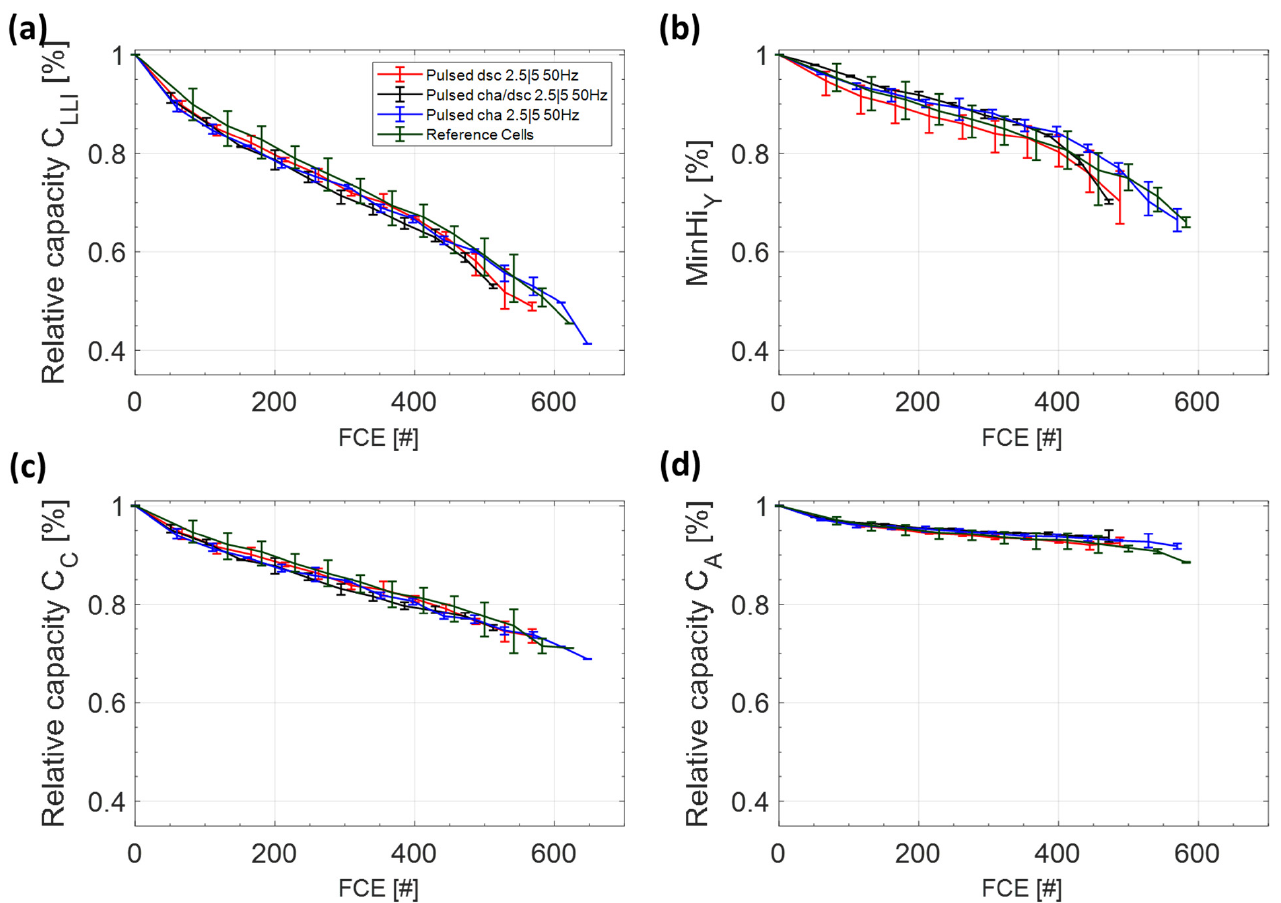
Figure 7. Trends in the loss of active lithium C LLI ( a ), the minimum at high SOC (MinHi) ( b ), the cathode C C ( c ) and the relative capacity of the anode C A ( d ) for the reference cells and the pulsed cells. show a similar trend with comparable small cell-to-cell variation. The highest deviation